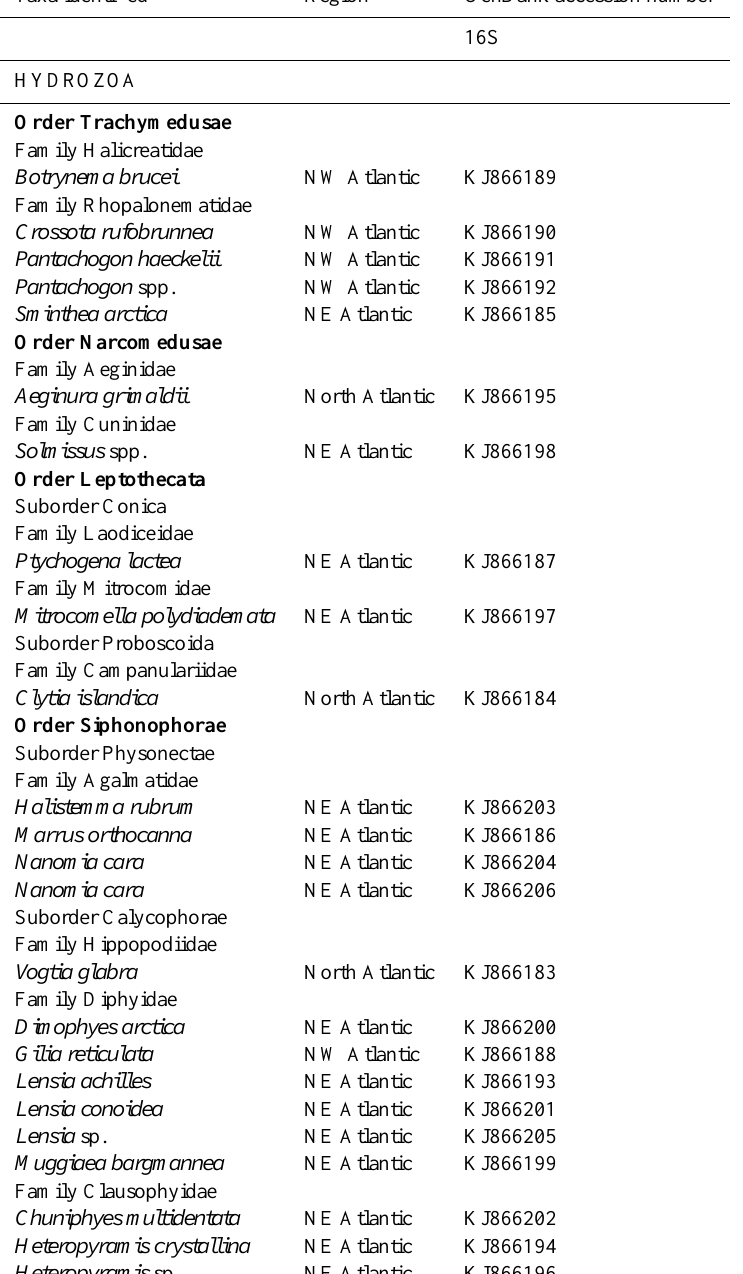
Table 9. DNA sequences (mt16S rDNA) identified from cnidarian taxa collected during project EURO-BASIN in different North Atlantic